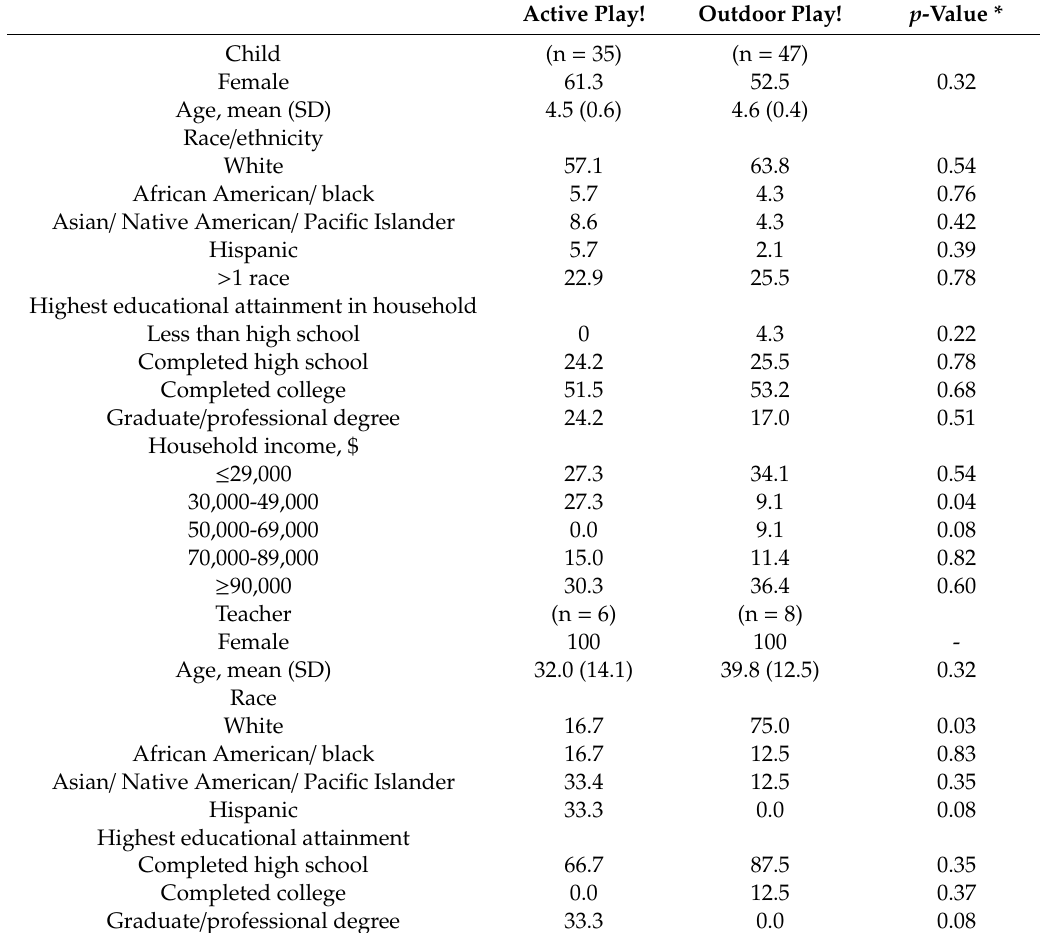
Table 2. Child and teacher demographic characteristics, % unless otherwise